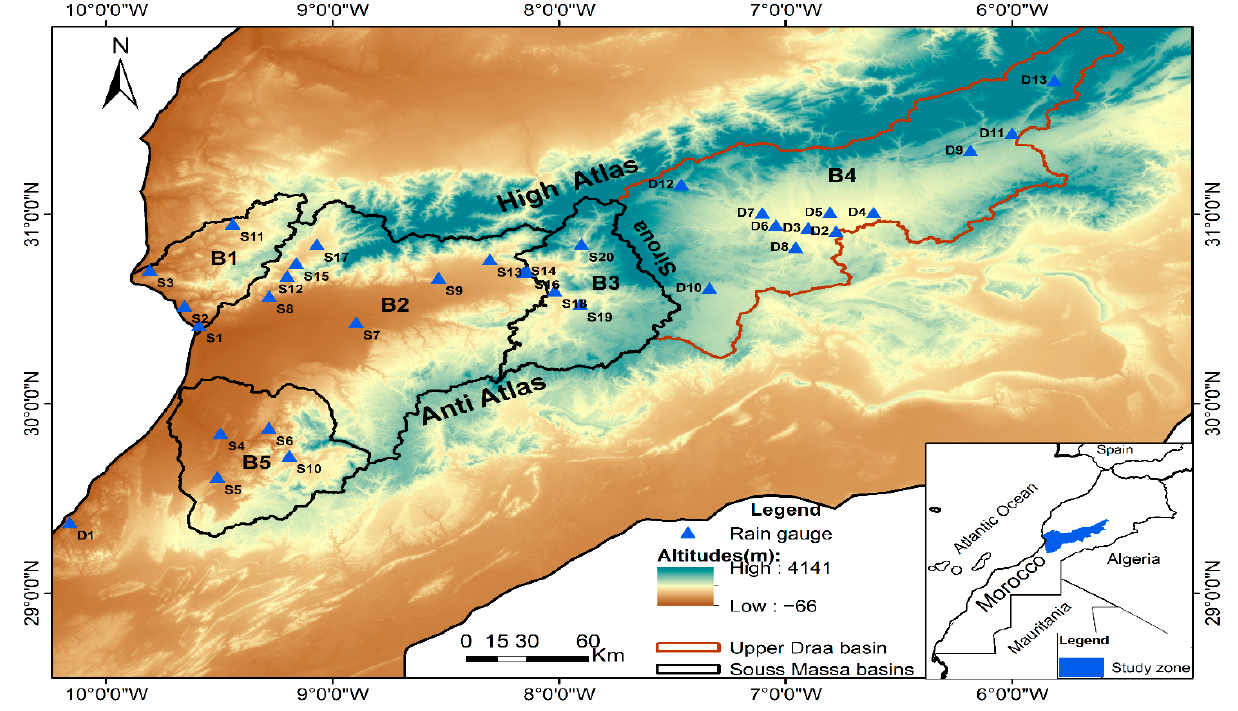
Figure 1. Location of the study area and rain gauges network. B1-B5: Basins.